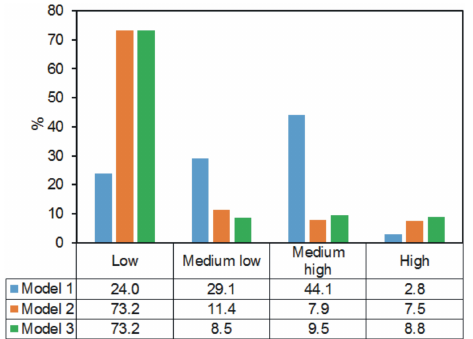
Figure 11. Percentages of the road network classified with low, medium-low, medium-high or high susceptibility to be affected by shallow landslides for each GAM